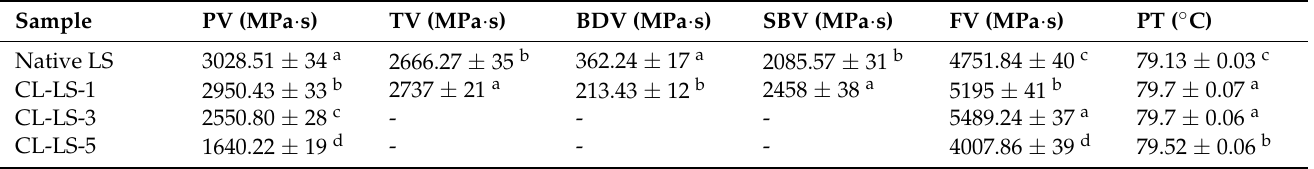
Table 2. Pasting properties of native and cross-linked lotus seed starch.